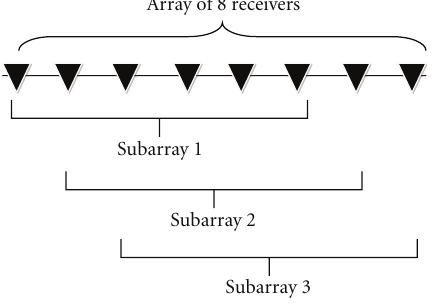
Figure 1: Time window used to compute semblance. The two red lines show the travel-time trajectories bounding the window used to select the data.